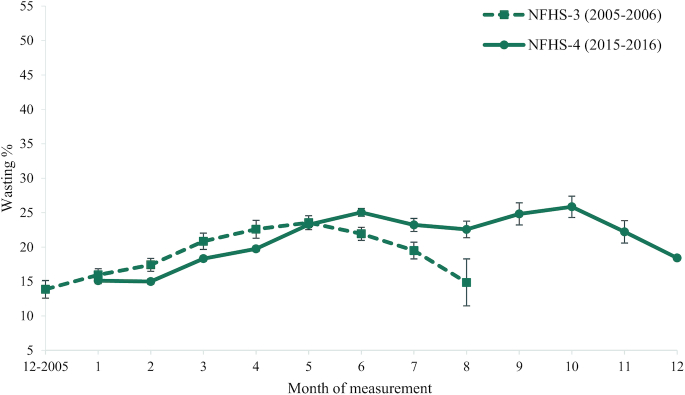
Weighted prevalence of wasting in India in NFHS-3 and NFHS- 4 India by month of measurement. Data presented as mean estimate and 95% CI. NFHS, National Family Health Survey.